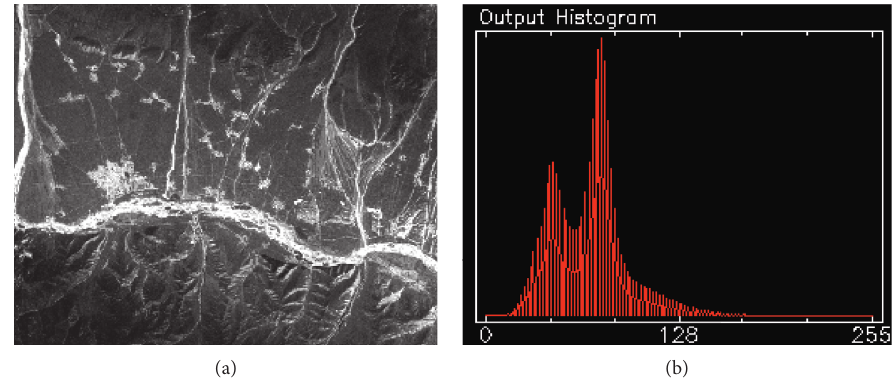
Figure 1: (a) 16 times hyperspectral remote-sensing image. (b) Grayscale values of hyperspectral remote-sensing images.